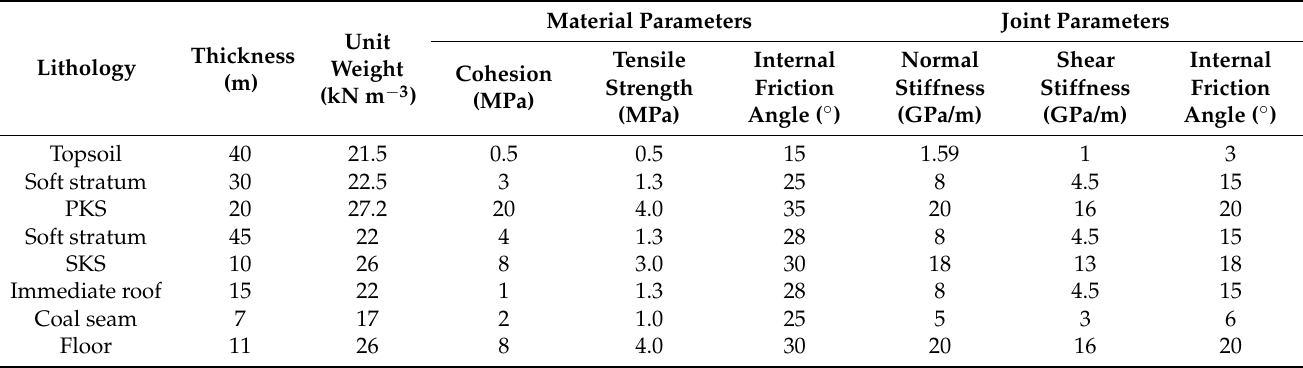
Table 5. Mechanical parameters of the overlying strata in numerical